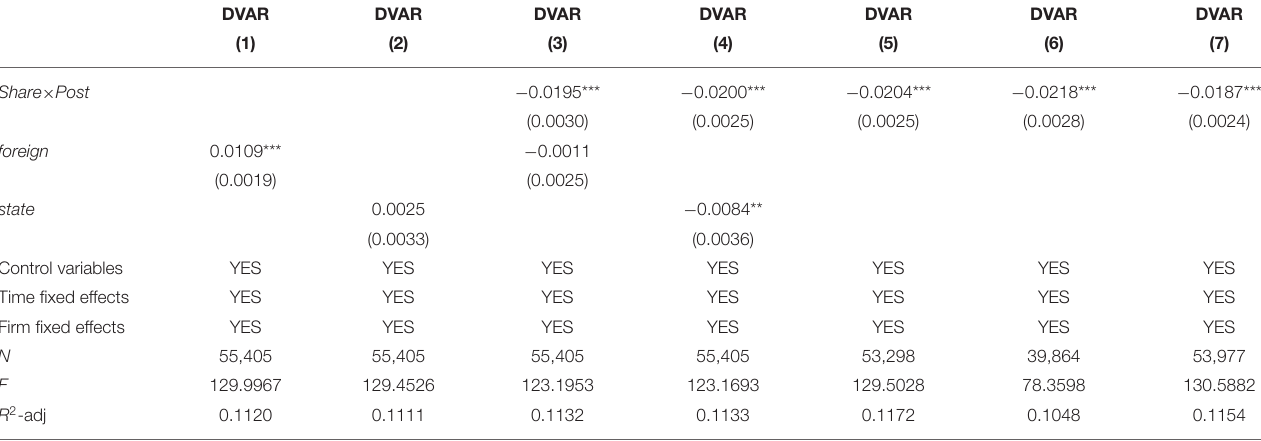
TABLE 4 | Firm ownership and sample selection bias.